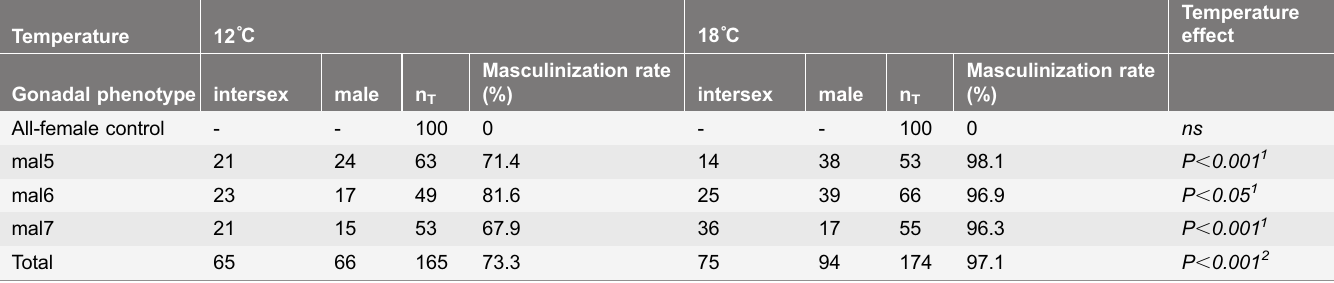
Table 3. Effect of temperature treatment on the masculinization rate in Experiment